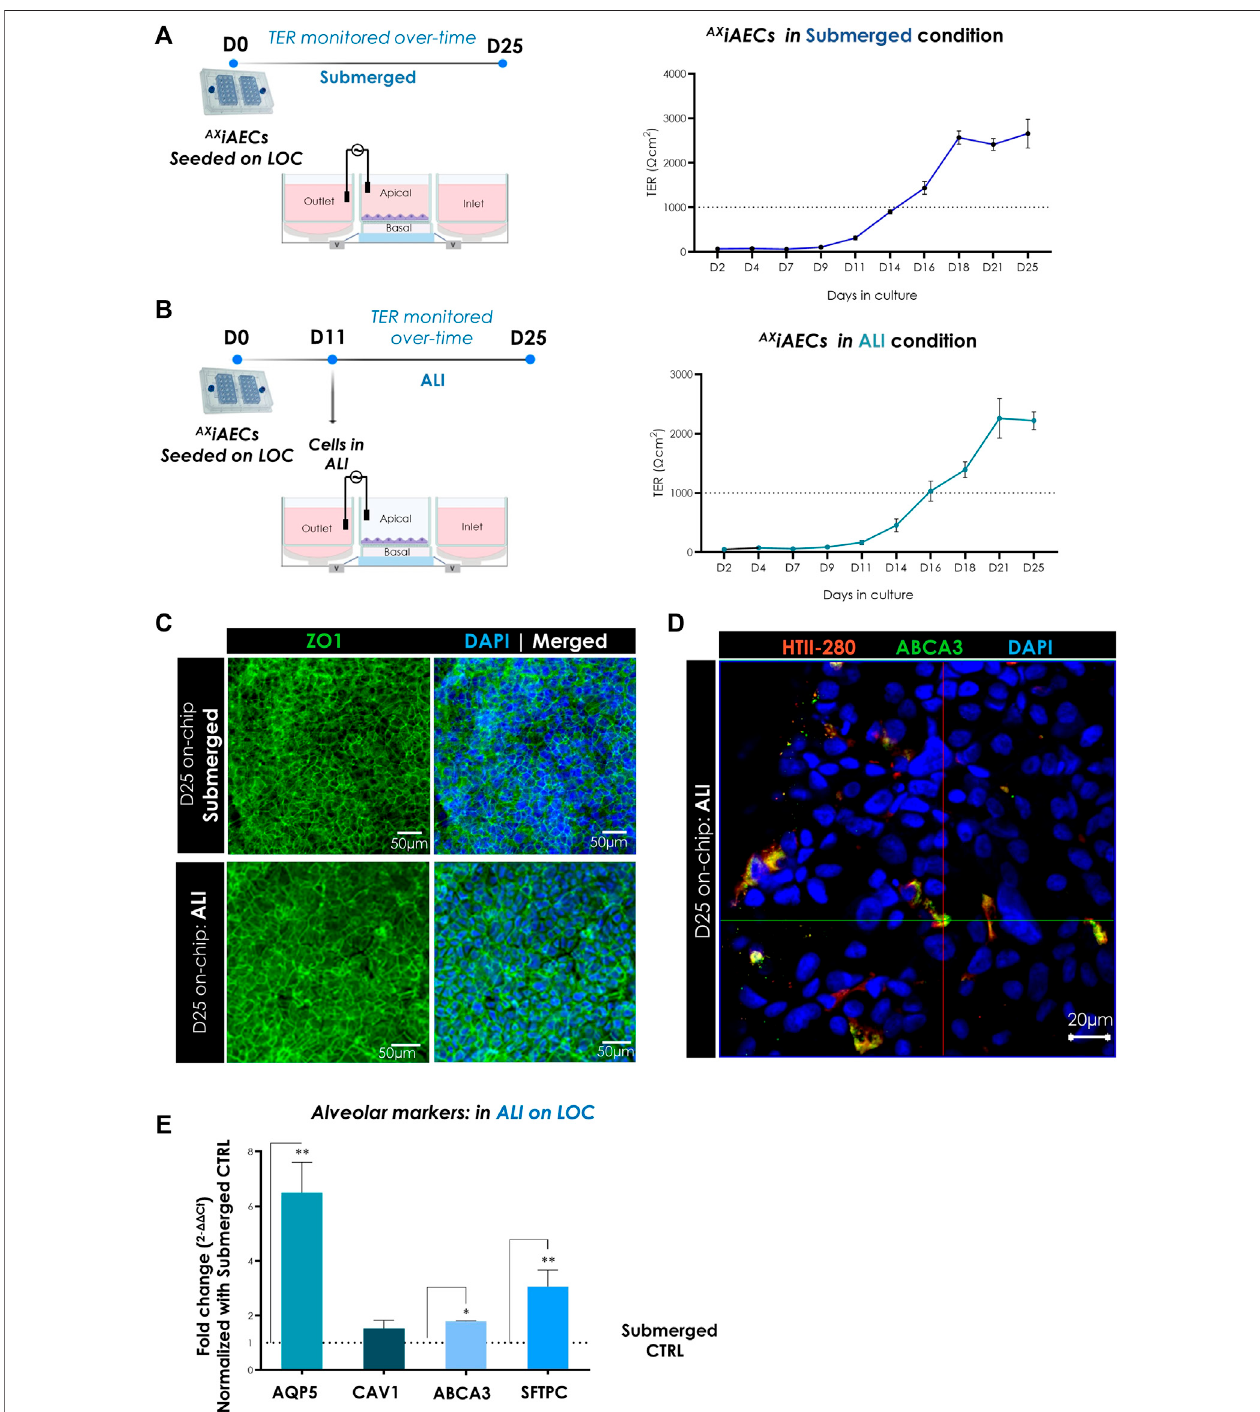
FIGURE 4 | Characterization of barrier formation on-chip. (A) Timeline and overall schematic of the AX iAECs cultured in submerged state on the AX12. TER ( Ω cm 2 ) valuesof AX iAECsinsubmergedconditionson-chipuntilday25(D25)areshown.TERvaluesabove1,000 Ω cm 2 wererecordedaroundday16(N=3; n =10). (B) Timeline and overallschematicofthe AX iAECsculturedinALIconditionstartingfromD5onwardson-chip.TER( Ω cm 2 )valuesof AX iAECsinALIon-chipmaintaineduntilday25(D25) areshown.TERvaluesabove1,000 Ω cm 2 wererecorded aroundday 16(N=3; n =9). (C) Representativeimagefor AX iAECsinsubmergedand ALIconditions, fi xed after25 daysculturein AX Lung-on-chip(D25)wasstainedforzonulaoccludens1(ZO-1;green).NucleiwerestainedwithDAPI(blue).Scalebar=50 µm. (D) Representative stainingof AX iAECsinALIconditionon-chipshowco-localizationofHTII-280andABCA3proteinson-chip. (E) Relativegeneexpressionofdistinctalveolarepithelialgenesin AX iAECsculturedinALIculturecomparedtocellsinsubmergedconditions(CTRL)ontheAX12(N=1; n =3).Datashownasmean±SEM,* p < 0.05,** p < 0.01,*** p < 0.001.